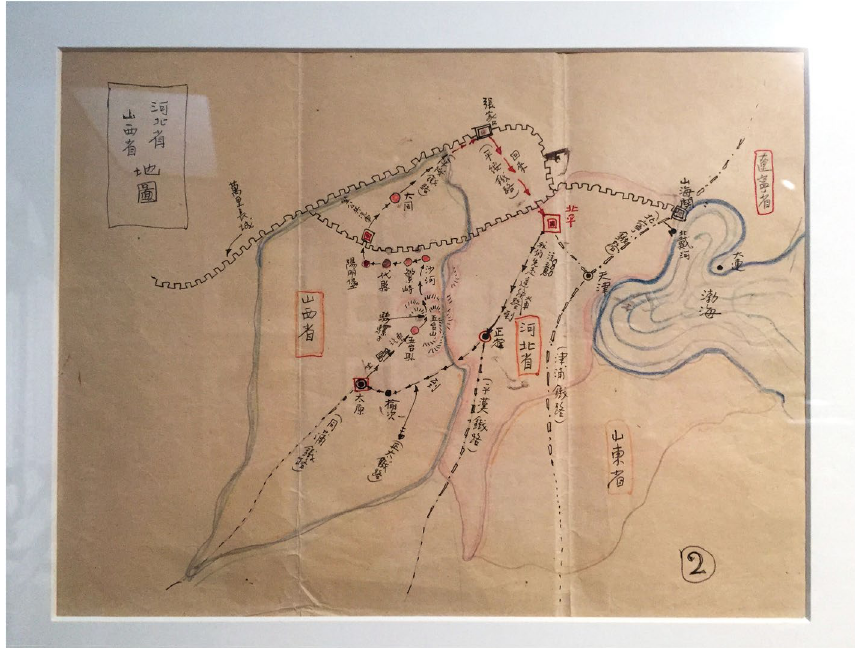
Fig. 4 Letter from Lin Huiyin and Liang Sicheng to Liang Zaibing (age 8 years at the time), with a hand-drawn road map related to surveys of